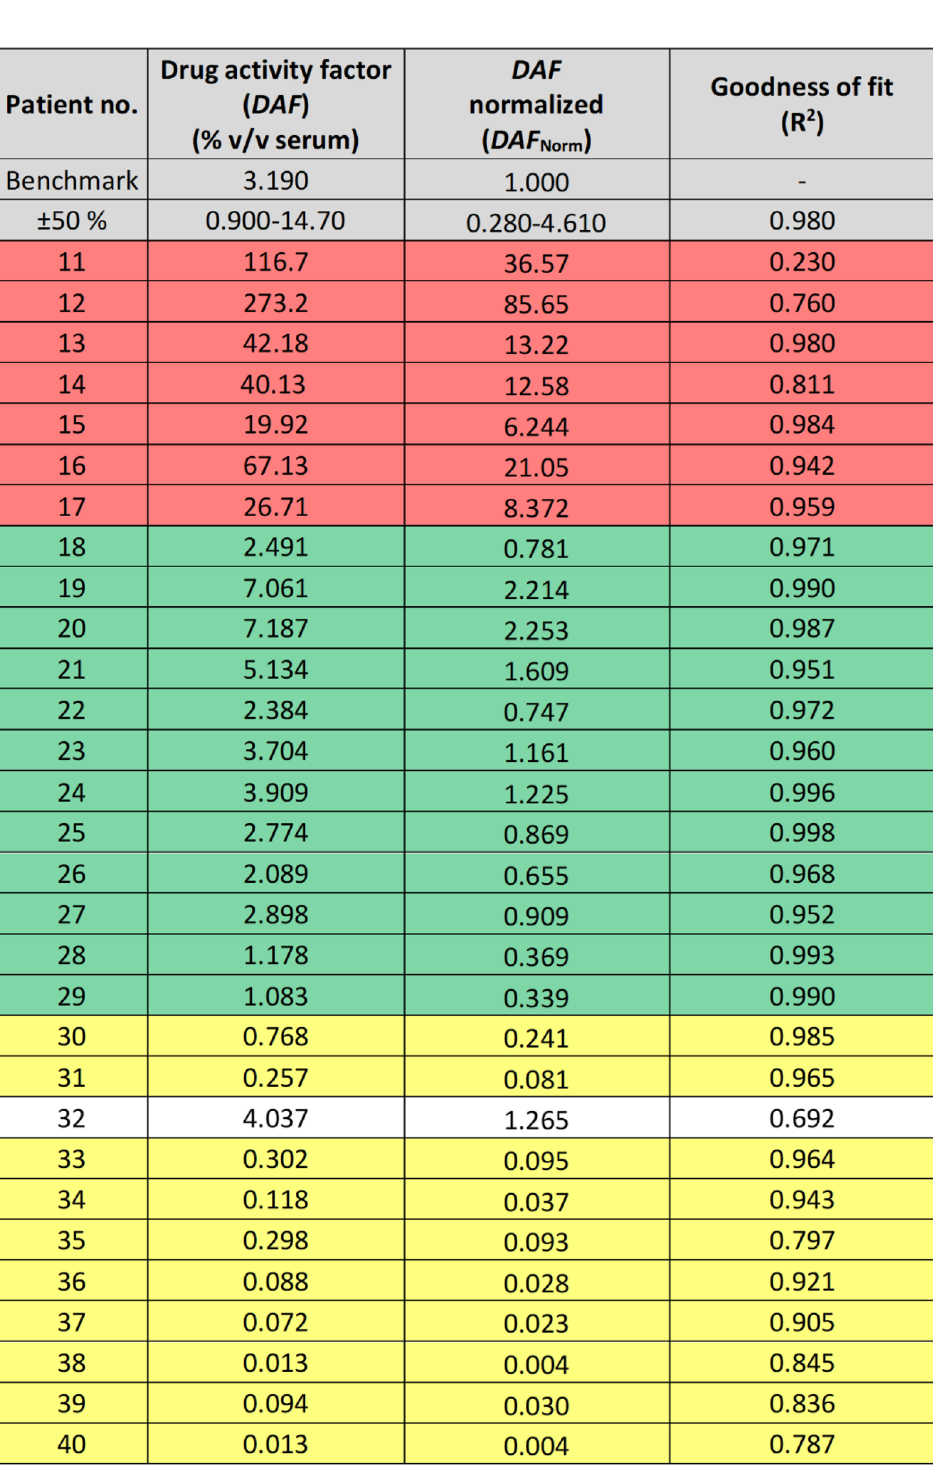
Table 1. Calculated drug activity factors (DAF) for the experimental group (30 patients), based on fitting to the excess indicator binding isotherm with parameters from the standard curve in 20% plasma [i.e., R complex = 8.71 nm, R indicator = 3.28 nm, and I = 19.40% serum (corresponding to 10.47 nM TNF-α)]. The red, green, and yellow color codes correspond to patients classified as NAb positive, normal responders, and non- NAb positive, respectively. Patient 32 showed signs of mixed mode ADAs, and was therefore not